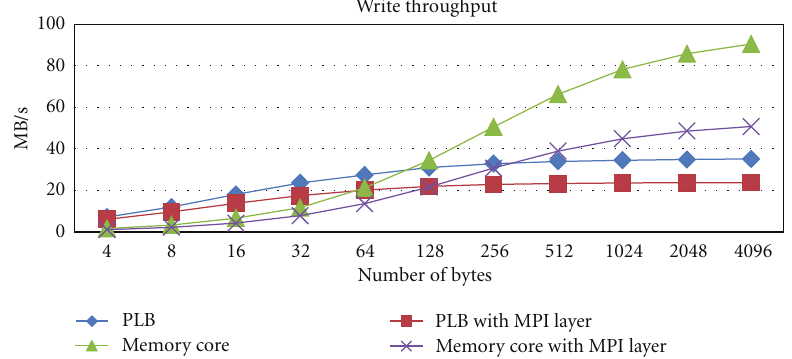
Figure 12: Comparison of the achievable write throughput in MB/s at 125 Mhz: Star-Wheels NoC and adaptive memory core versus PLB and Xilinx MPMC controller, both with and without MPI layer.